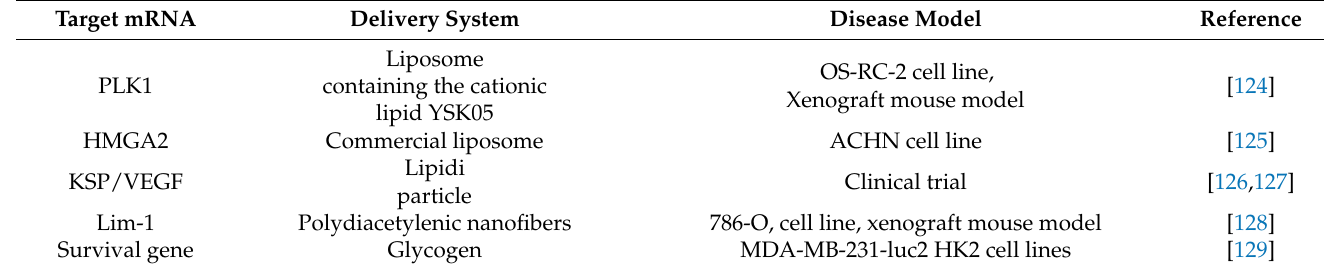
Table 4. siRNA delivery in renal